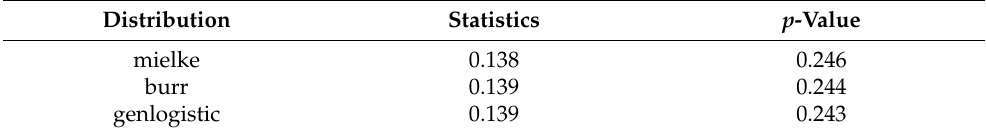
Table 1. Top three distributions to fit the BCG Strains Dataset.